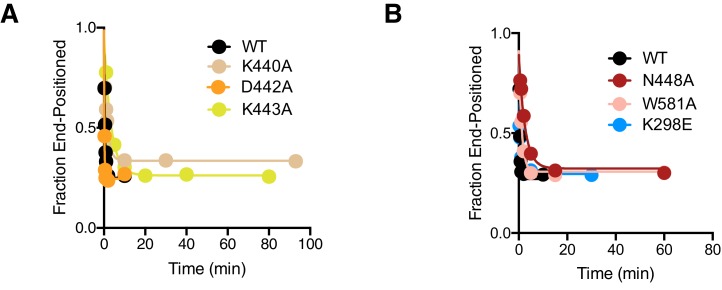
Full fits of native gel remodeling assays.Complete time courses from Figure 3D (A) and Figure 4B (B) shown with longer time points.